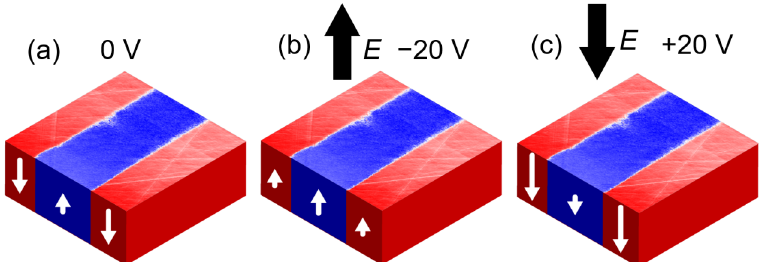
Fig. 4 Schematics of OP polarization components of the KNN single crystals in the as-grown state (Figs. 1(a) and 1(b)) and under electric fields. (a) As-grown state of the crystals, showing the directions and magnitudes of the spontaneous OP polarization components within the middle and side domains. (b) Under the maximum negative voltage, OP polarization components of the middle and side domains are aligned along the electric-field direction (upwards) but with different magnitudes (smaller in side domains). (c) Under the maximum positive voltage, OP polarization vector components of the middle and side domains are aligned along the electric-field direction (downwards) but with different magnitudes (much larger in side domains). The lengths of the arrows represent the magnitudes of polarization components, corresponding to the amplitudes of hysteresis curves in Fig.